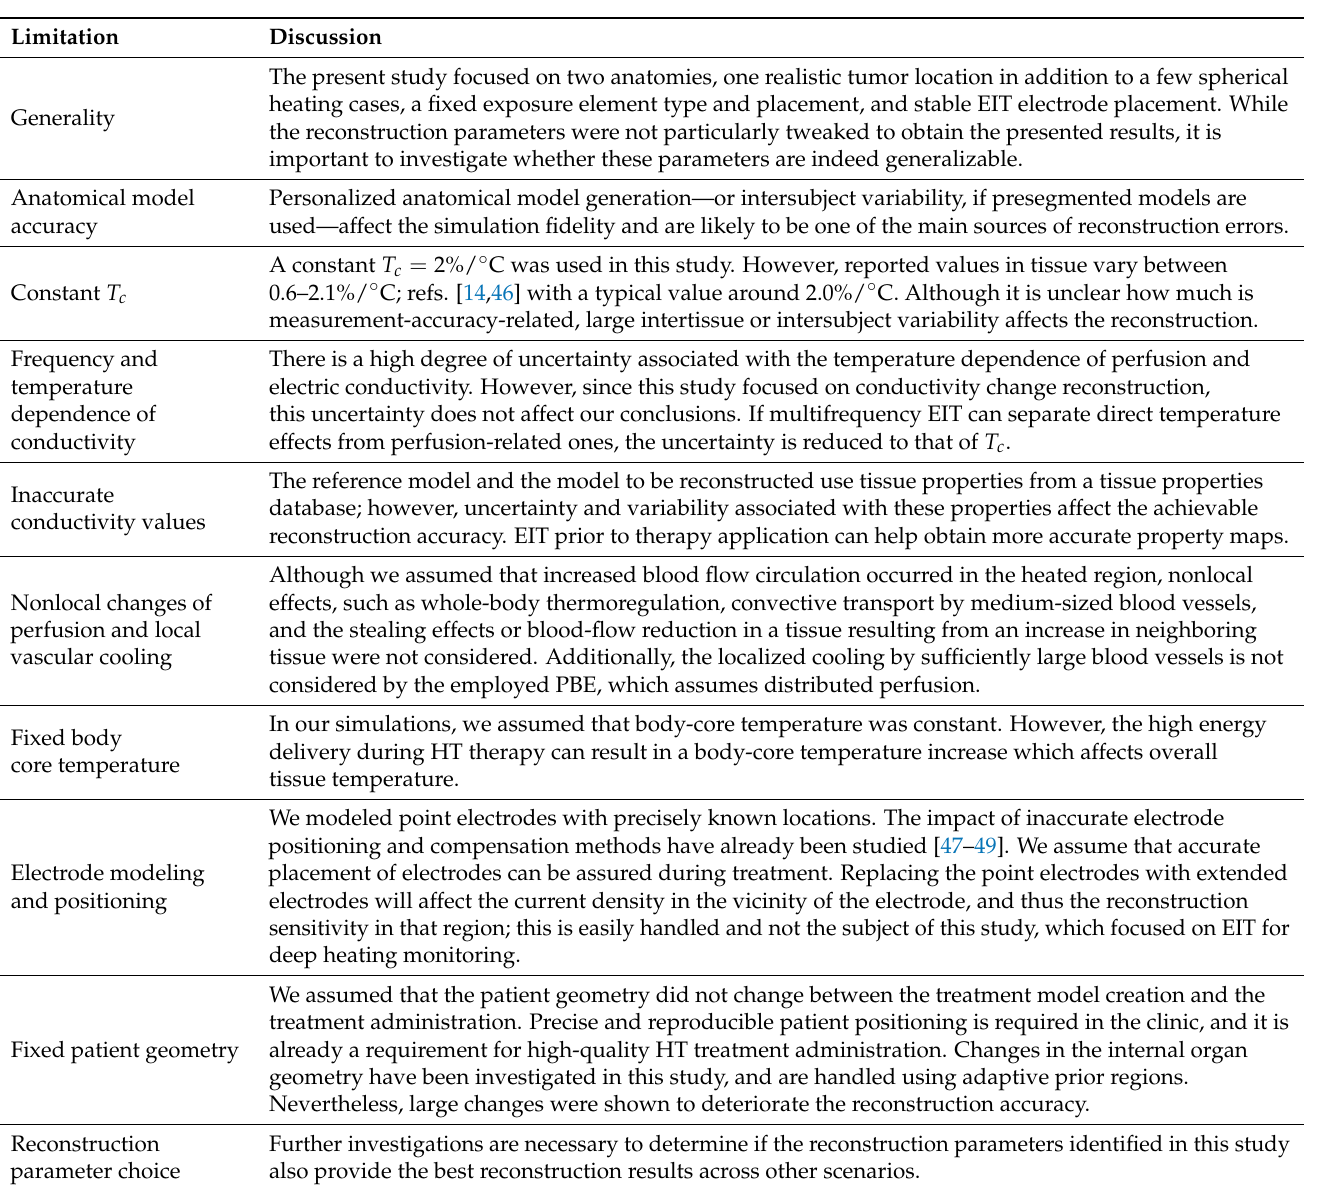
Table 4. List of limitations in this study and their